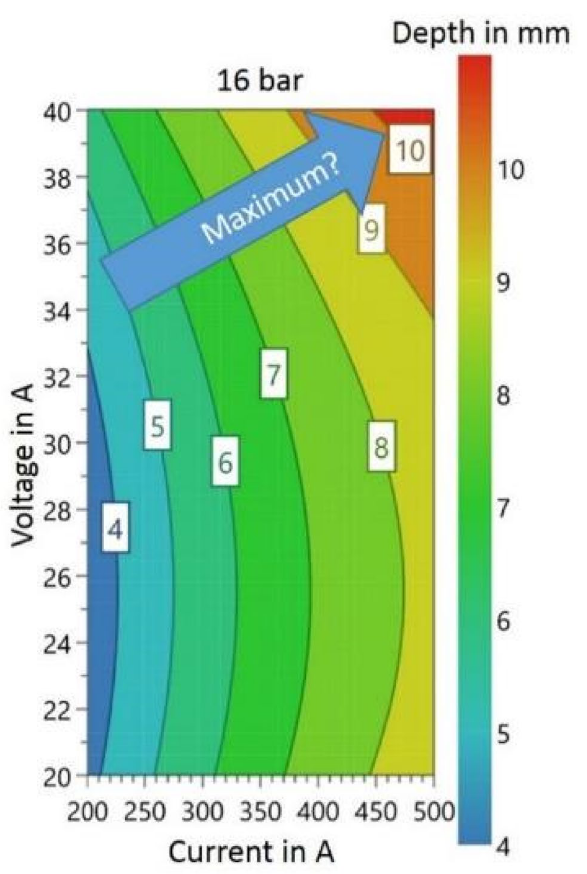
Figure 7. Assumed local maximum in the statistical